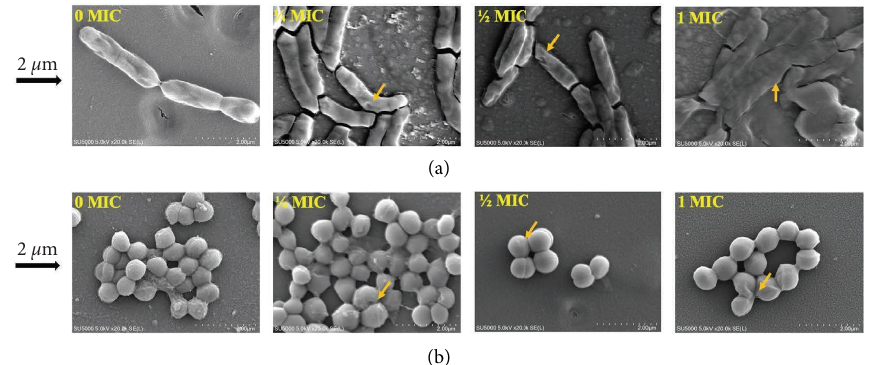
Figure 2: Scanning electron micrograph images of A. sobria (a) and S. saprophyticus (b) after KA treatment at diferent densities at 30 ° C for 24h. Te scale bar represents 2 μ